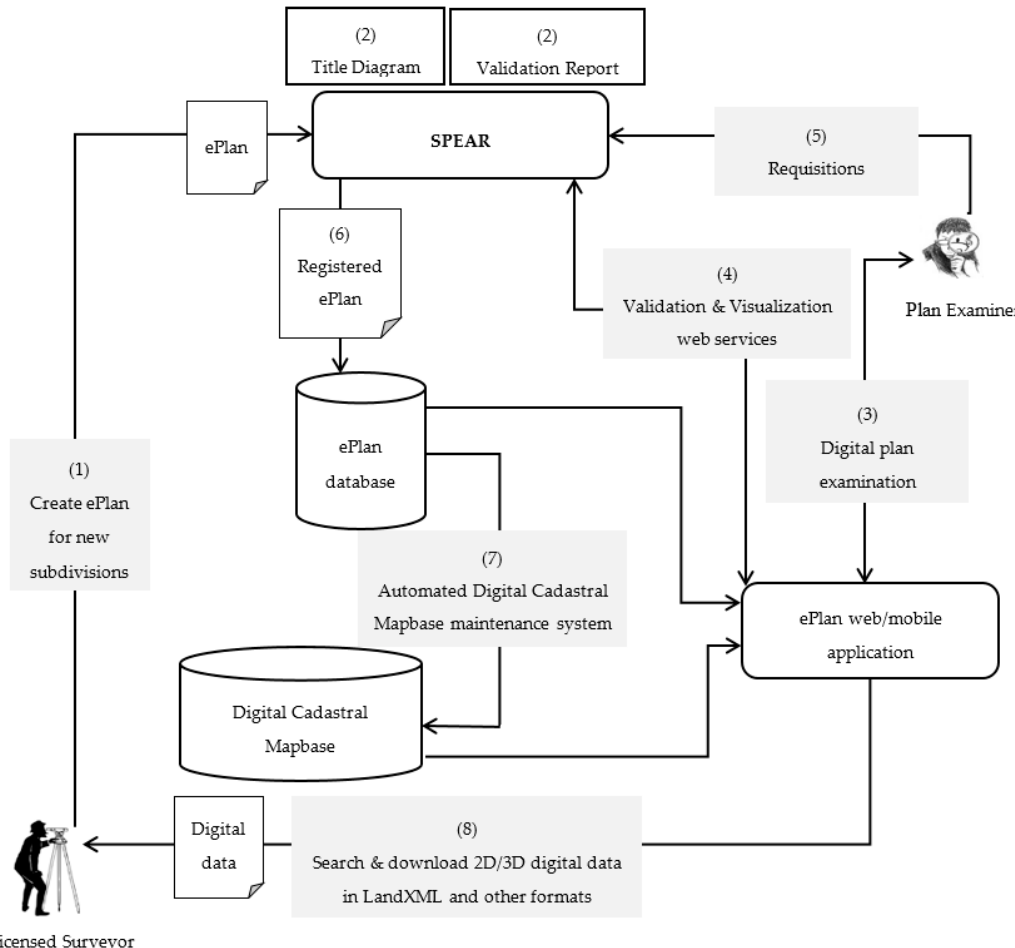
Figure 4. Future ePlan workflow.